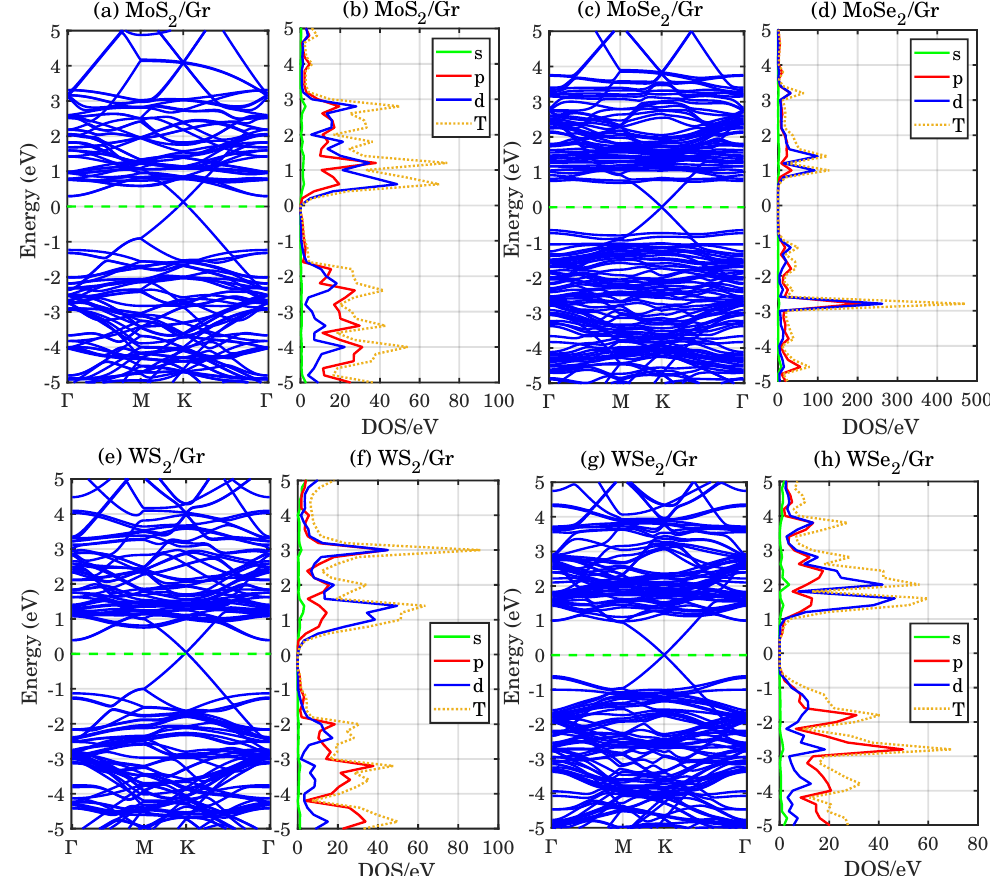
Figure 2. The energy band structures and the DOS for the MX 2 /Gr van der Waals heterostructures. The partial DOS values are labeled with s, p, or d, corresponding to the orbital contributions, and the total DOS is labeled with T. ( a , b ) MoS 2 , ( c , d ) MoSe 2 , ( e , f ) WS 2 , ( g , h ) WSe 2